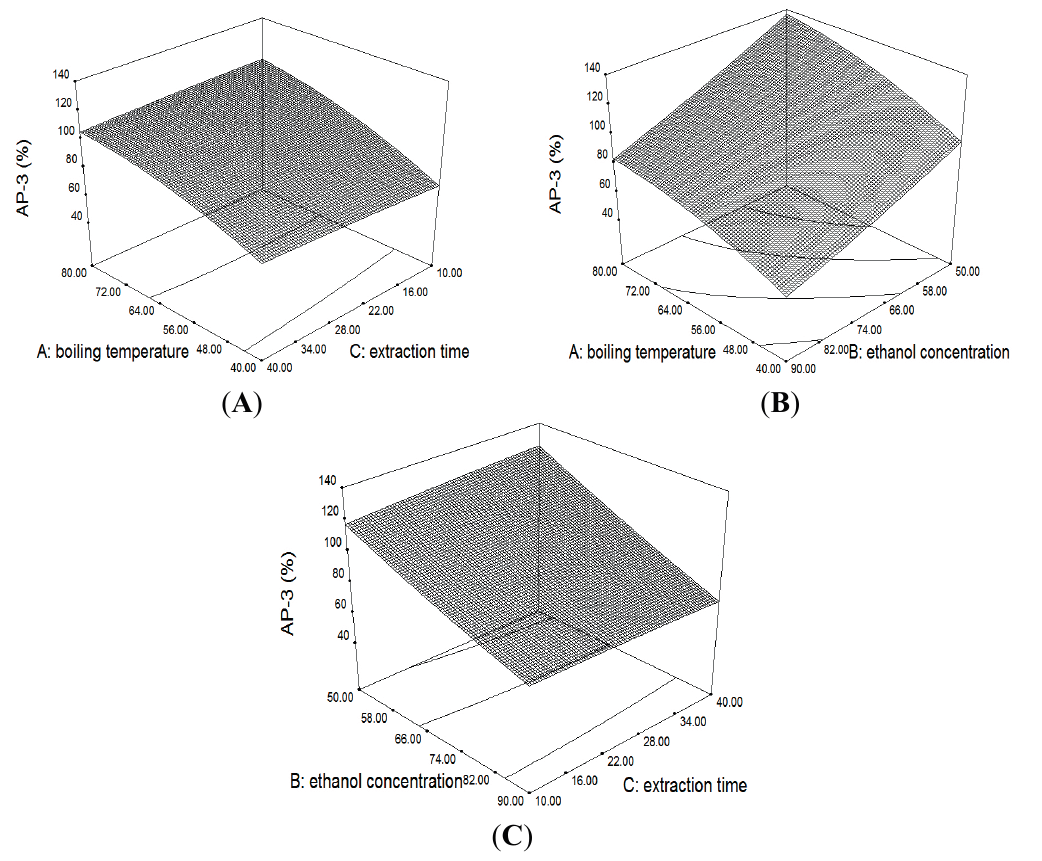
Figure 4. 3D surface and contour plot showing the effect of variables on the extraction yield of AP 3